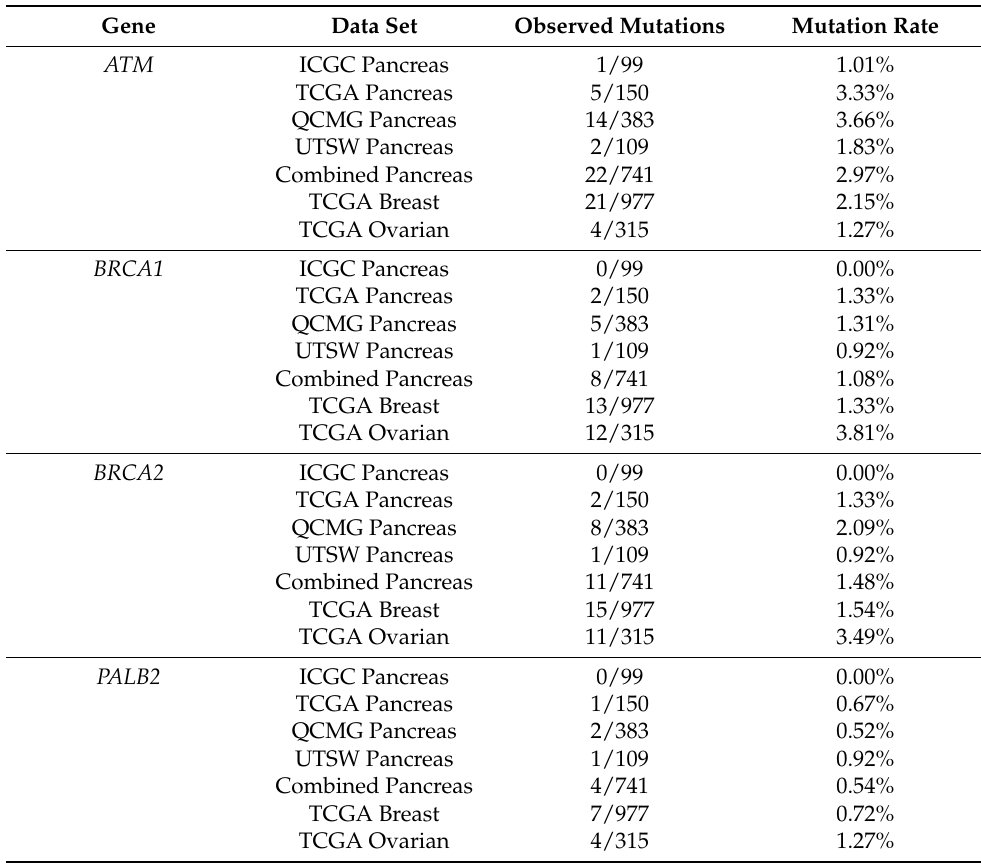
Table 1. Rates of ATM , BRCA1 , BRCA2 , and PALB2 mutations in publicly available genomic datasets of PDAC patients compared to other tumor types.